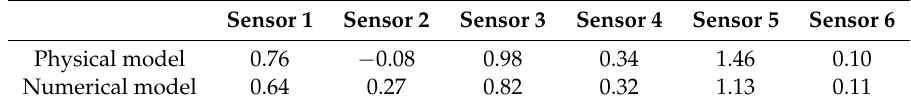
Table 3. Comparison between mean pressures computed in the physical and in the numerical model in the secondary dam at discharge flow rate of 300 m 3 /s. Pressures are in meters of water